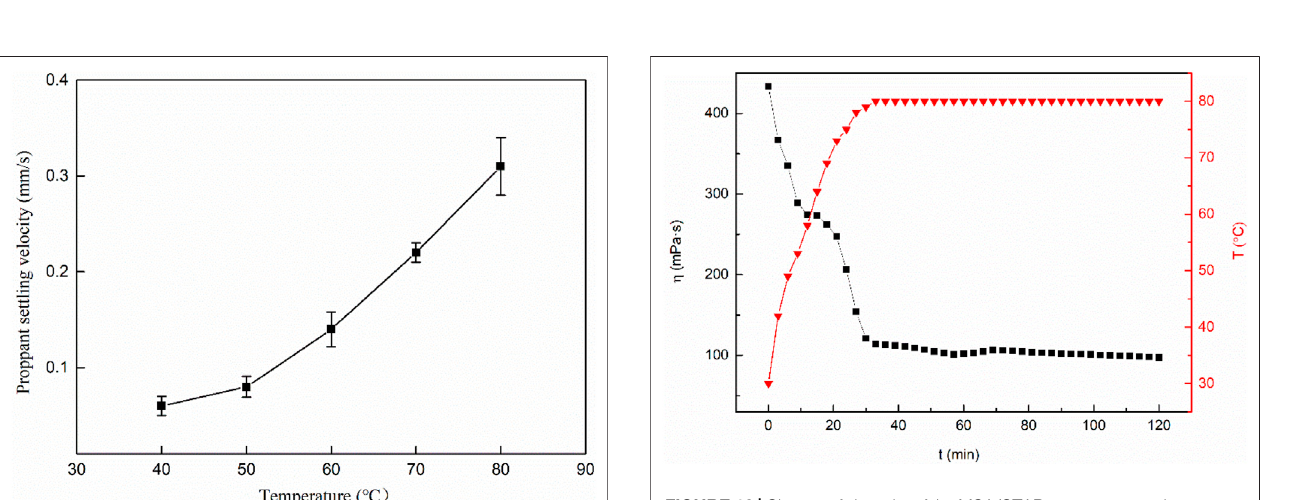
FIGURE 12 | Change of viscosity of the MSA/CTAB system versus time showing the heat and shear resistance of the system.